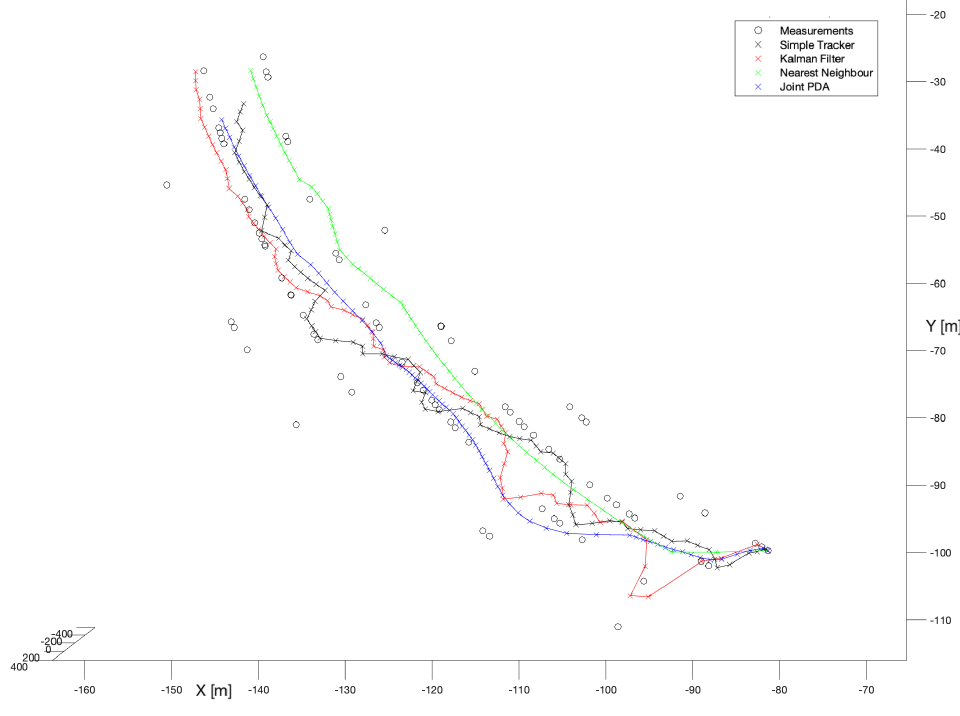
Figure 5. Performance of all